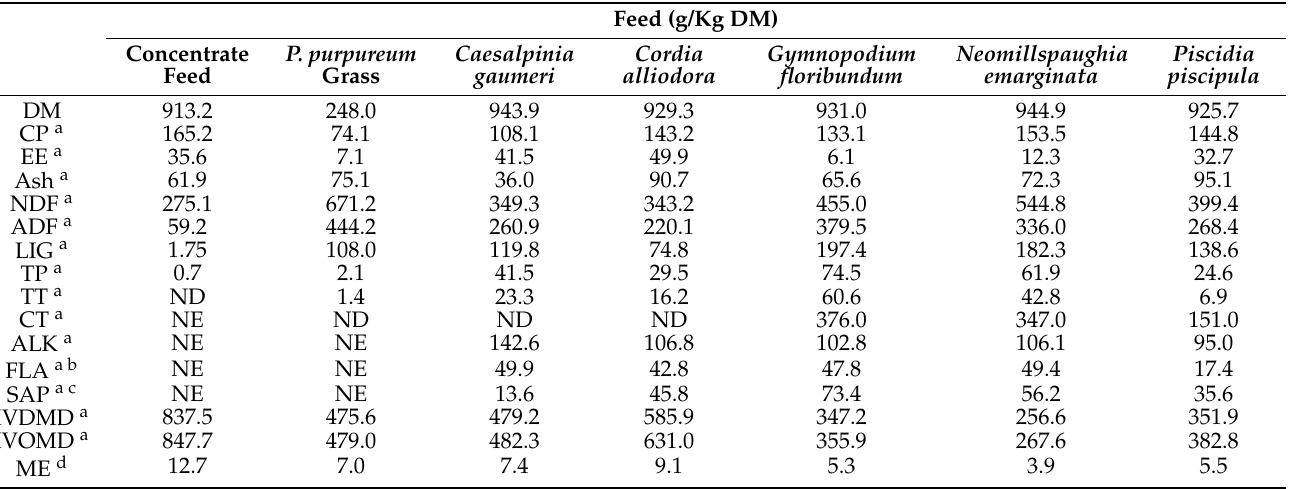
Table 1. Chemical composition a , secondary metabolite content, in vitro dry matter and organic matter digestibilities, and the metabolizable energy of feeds offered to juvenile goats (Concentrate feed, Pennisetum purpureum grass, and the six experimental forage